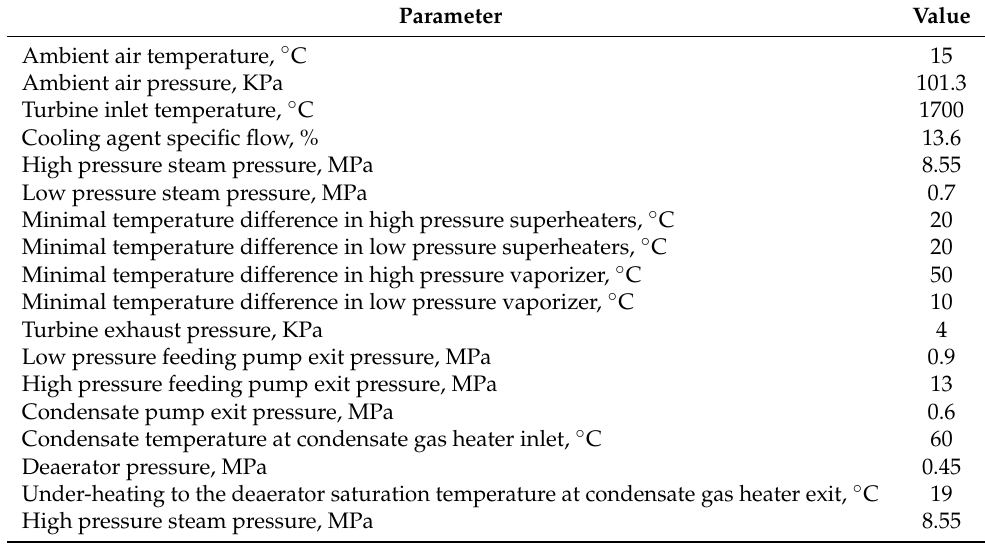
Table 4. Heat flow analysis input data.